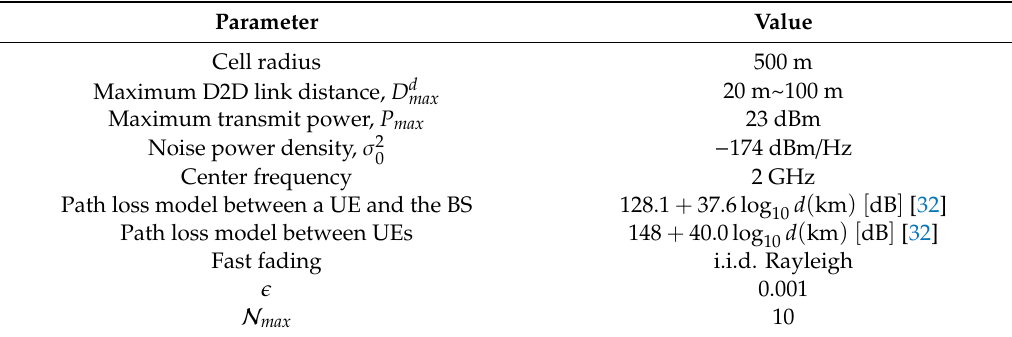
Table 2. Simulation